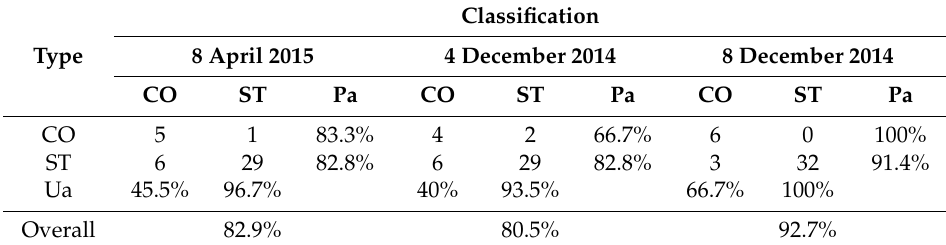
Table 2. Classification results with only first-order statistics (CO = totally collapsed building, ST = standing building; Pa = producer’s accuracy, Ua = user’s accuracy).